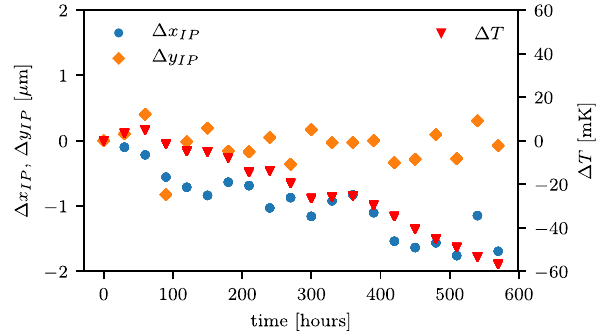
¼ x ð t Þ − IP IP